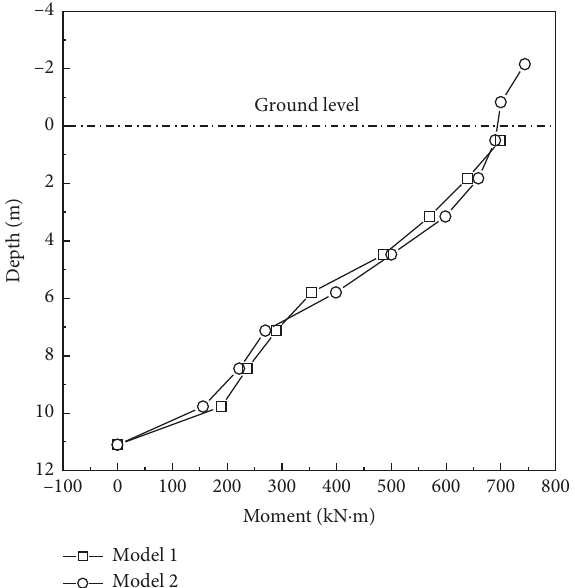
Figure 21: Contrastive analysis of horizontal displacement of inclined piles.